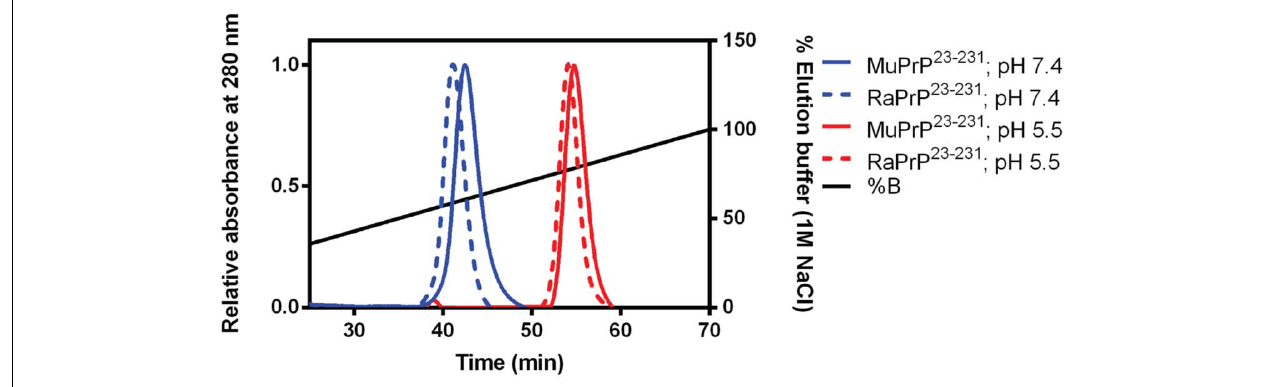
FIGURE 4 | Murine and Rabbit PrP 23 − 231 interaction with Heparin. Affinity chromatography of a heparin column of MuPrP 23 − 231 (solid) and RaPrP 23 − 231 (dotted) at pH 7.4 (in blue) and pH 5.5 (in red). Representative data from three experiments.